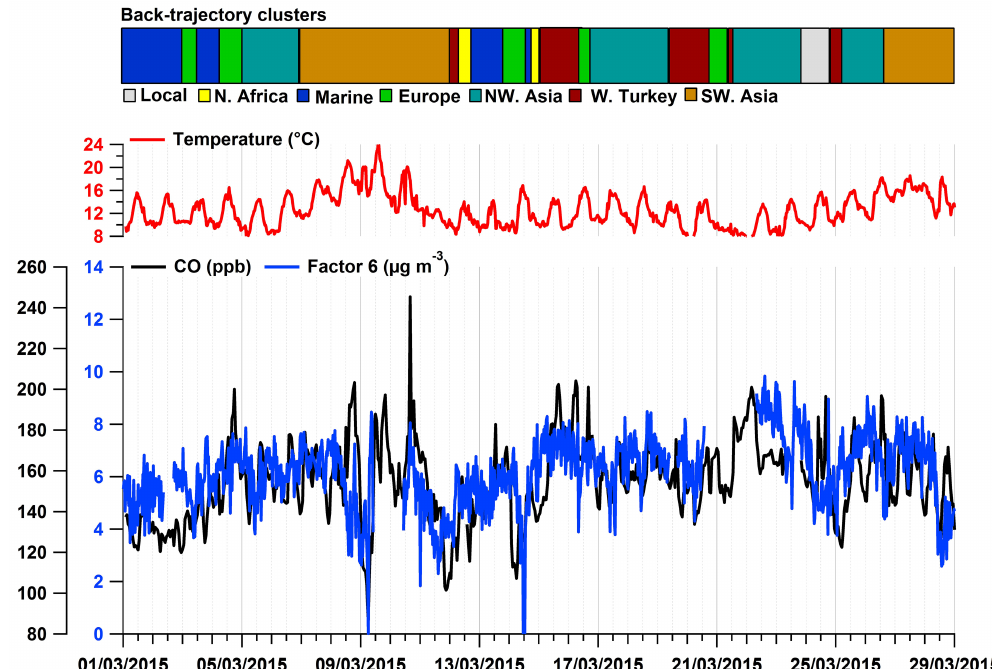
Figure 12. Time series of the VOC factor 6 contribution (blue line) and CO (dark line).